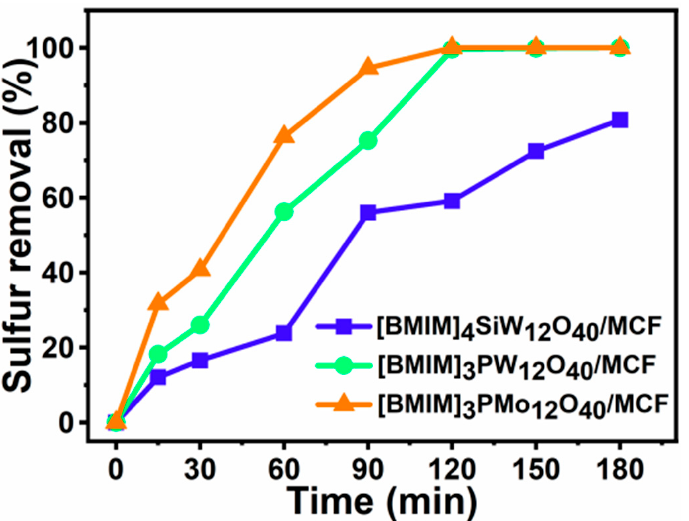
Figure 7. Sulfur removal of DBT with di ff erent catalysts. Experimental conditions: T = 60 °C, V DBT = 5 mL, V IL = 3 mL, O/S = 6, and t = 3 h.